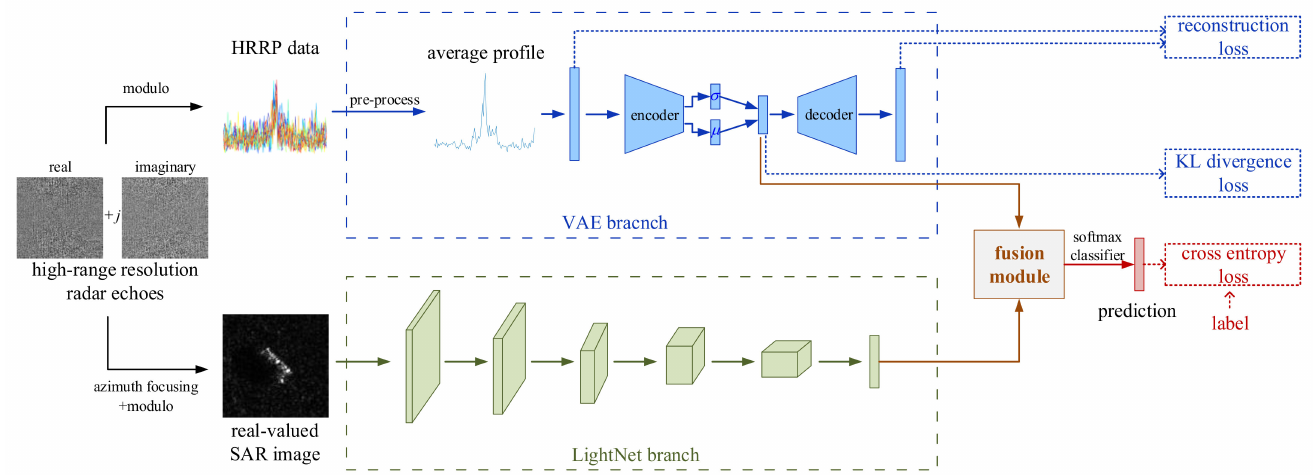
Figure 2. Framework of the proposed two-stream deep fusion network. Here the black solid lines and arrows represent the acquisition of inputs of the two sub-network branches, the blue solid lines and arrows represent the information flow in the VAE model, the green solid lines and arrows represent the information flow in the LightNet, the brown solid lines and arrows represent the information flow in the fusion module, and the red solid lines and arrows represent the final classifier. µ and σ represent the learned mean and standard deviation from the VAE encoder. The dotted line indicates the calculation of